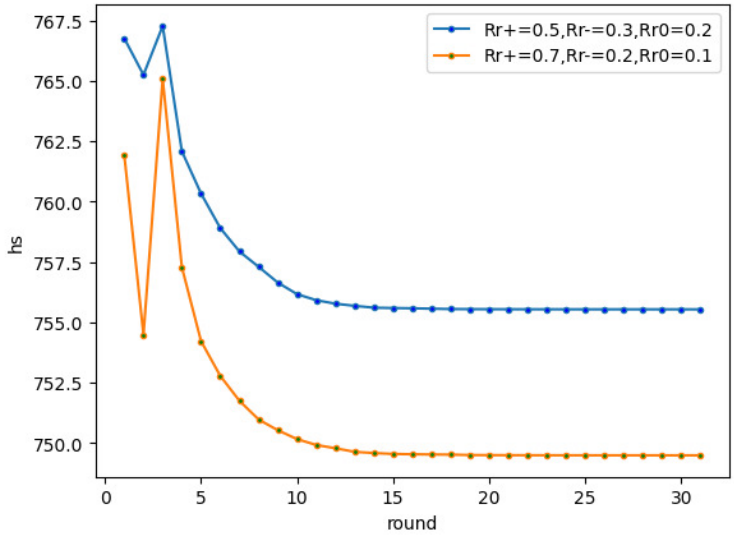
Figure 13. Effects of different initial ratios of positive edges: h s changes with